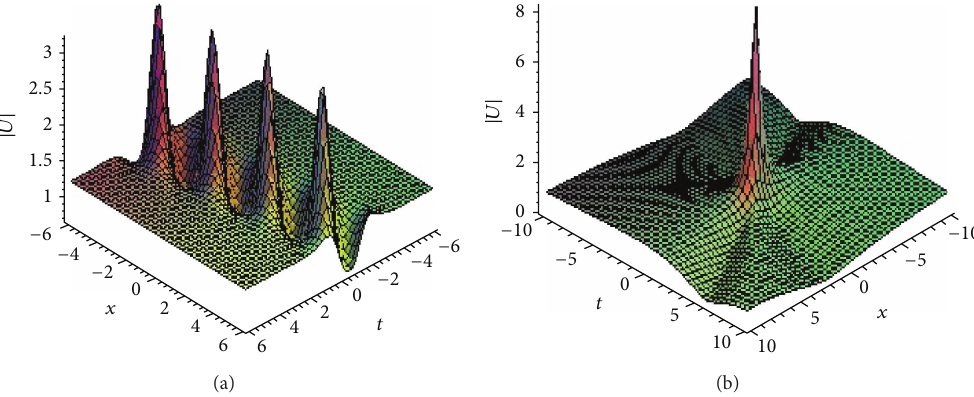
Figure 4: (a) Bright breather structure |𝑈| in DSII. (b) Bright rogue wave |𝑈| in DSII.